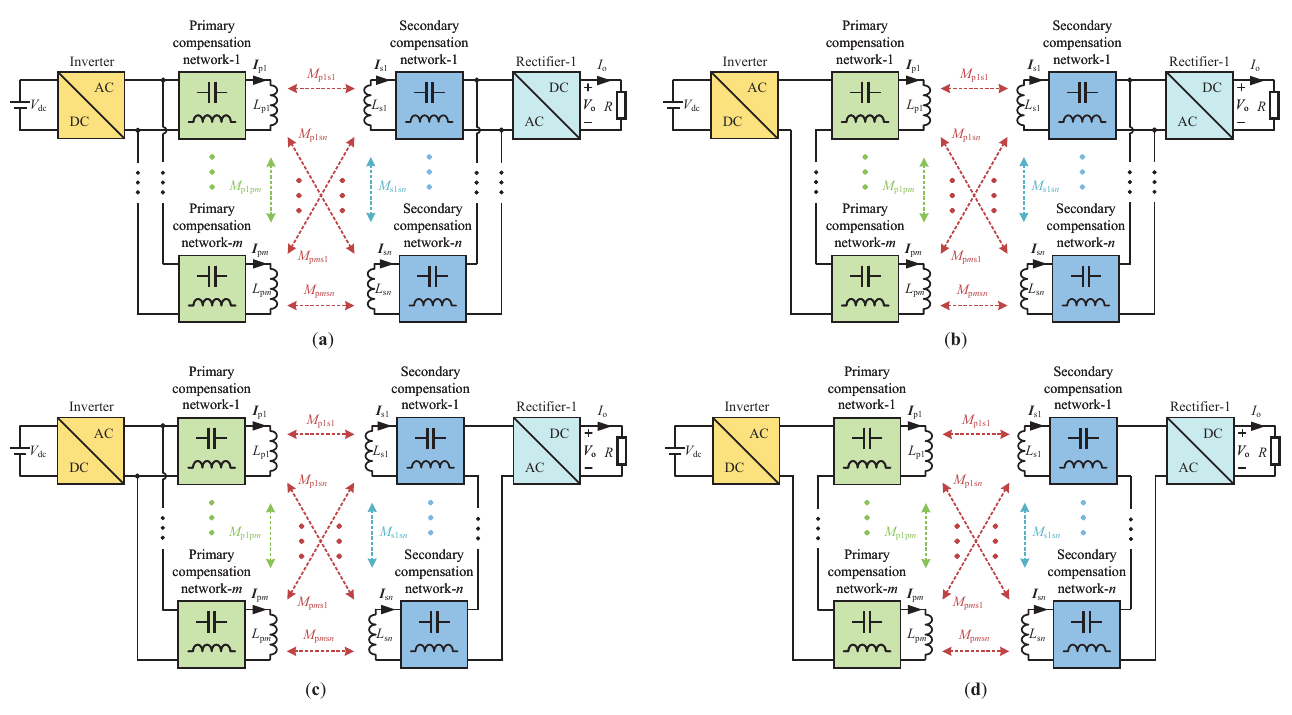
Figure 3. Schematics of the hybrid compensation topologies. ( a ) IPOP topology [77]. ( b ) ISOP topology [78,79]. ( c ) IPOS topology [80]. ( d ) ISOS topology [81,82].